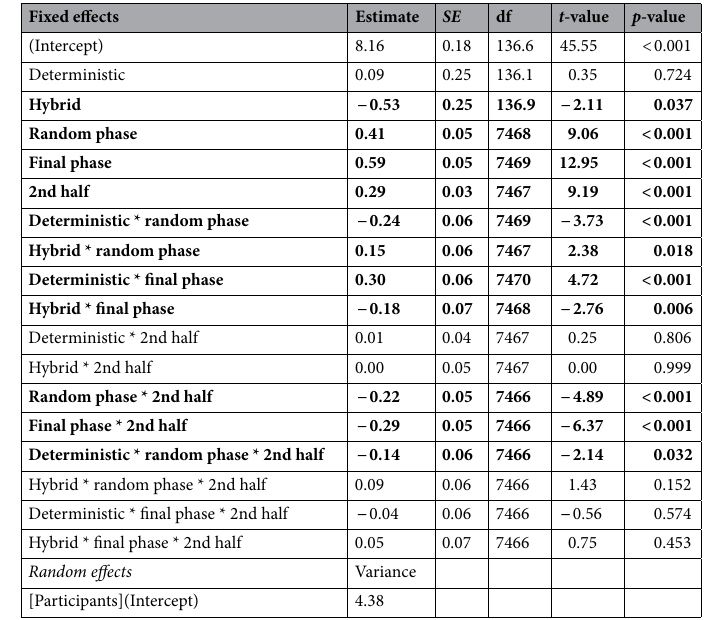
Table 2. Summary of the linear mixed-effects model testing the effects of outcome predictability and experience (Model 1). Dependent variable: Number of pumps on non-burst balloons. Coding scheme: sum coding. The reference levels of the factors were probabilistic condition, first phase, and 1st half. Significant effects are in bold (except the intercept). SE : standard